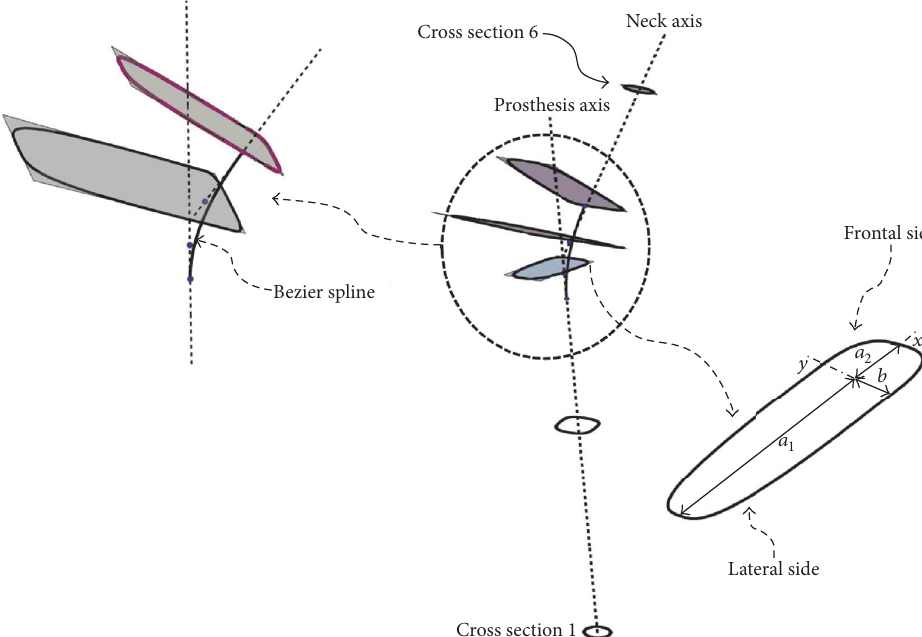
Figure 2: Skeleton of the hip implant. Each cross section is characterized by three geometrical parameters ( 𝑎 1 , 𝑎 2 , 𝑏 ) in addition to the exponent ( 𝑝 ) in (1). A four-point Bezier spline interpolated the sharp transition between the neck and prosthesis axes.